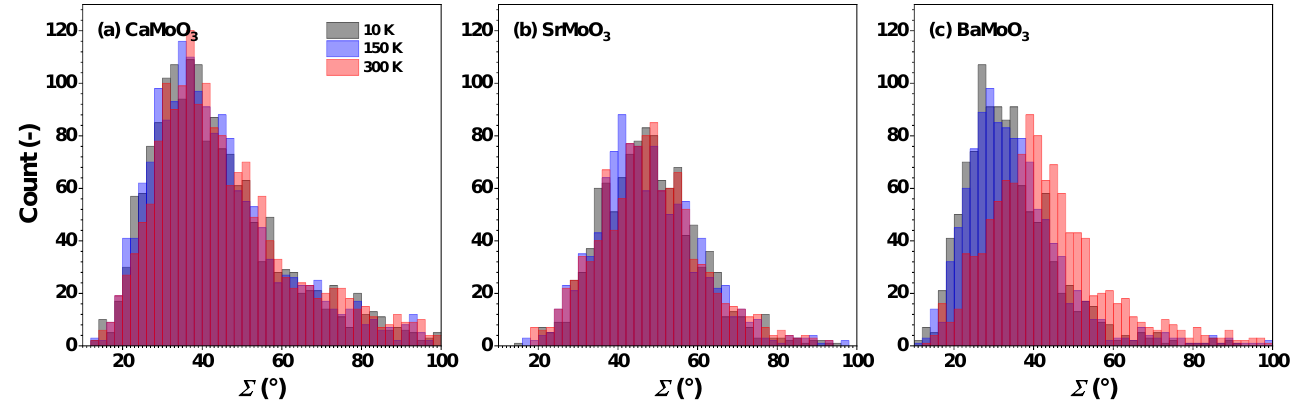
Figure 9. Histograms of calculated Σ values (Equation (2)) describing the angular distortion of [MoO 6 ] octahedra in polycrystalline ( a ) CaMoO 3 , ( b ) SrMoO 3 , and ( c ) BaMoO 3 at 10 K, 150 K, and 300 K. See text for details.